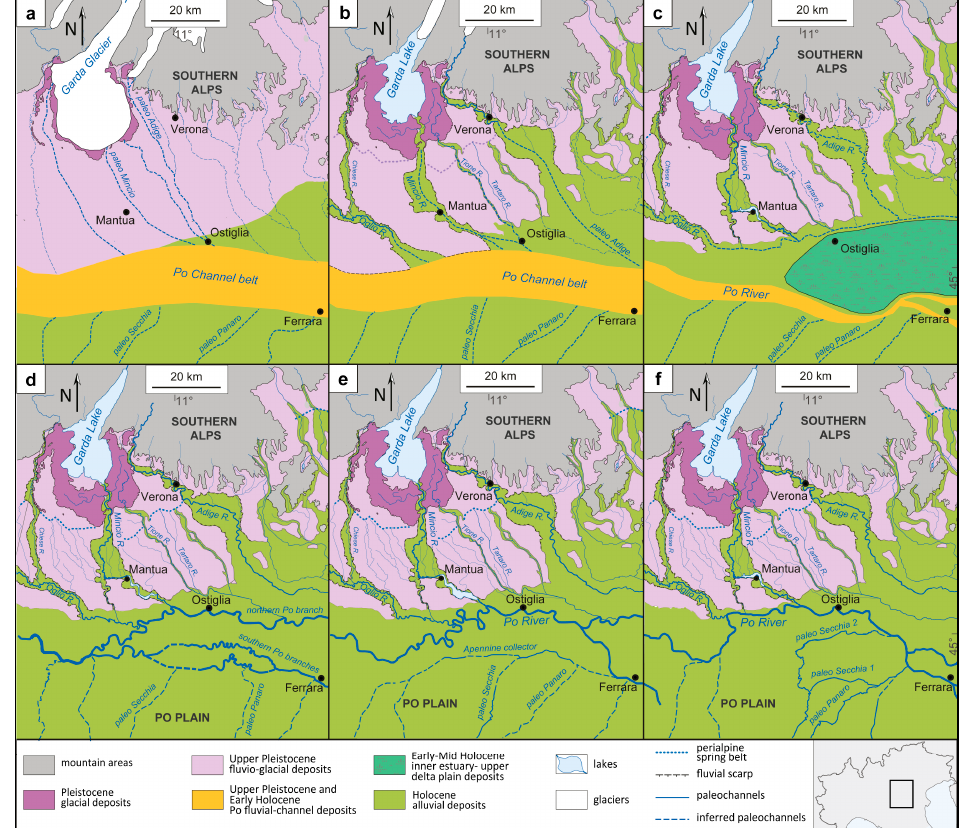
Figure 7. Main hydrographic changes of the Po Plain. Paleogeographic sketch maps showing the Po river network and depositional environment during ( a ): the Würmian glacial stage; ( b ): deglaciation; ( c ): maximum marine ingression; ( d ) Bronze Age–Iron Age; ( e ) Roman period; ( f ) Middle Ages. Extent of the Garda glacier during LGM is from [38]. Extent of Upper Pleistocene fluvio-glacial deposits are from [27]. Hydrography of the Mantua area during the Bronze Age and Roman period is from [45]. Paleogeographic information from [10,14,42,47–49] were also considered. The integrated stratigraphy and sand composition from the Ostiglia area records an overall transition from a river system marked by a high south-Alpine sediment supply (units U1 and U2) to a fluvial system dominated by the Po sedimentary input, with a not negligible Apennine influence. This tendency reflects: (i) the deactivation of the south-Alpine fluvioglacial systems at the transition from the last glacial to the present interglacial; (ii) the progressive northward migration of the Po River during the Holocene [25,50];